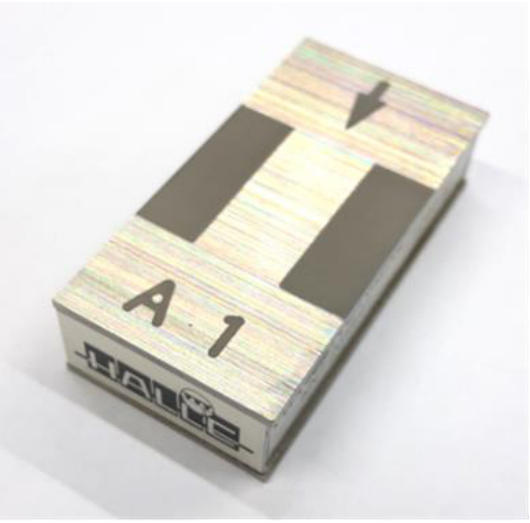
Figure 3. Roughness standard used in the ILC, LMM-R-2019.